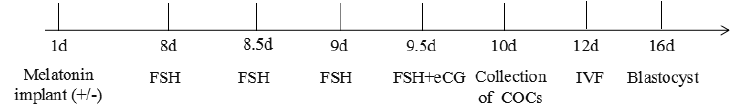
Figure A1. Superovulation scheme ( n = 9).